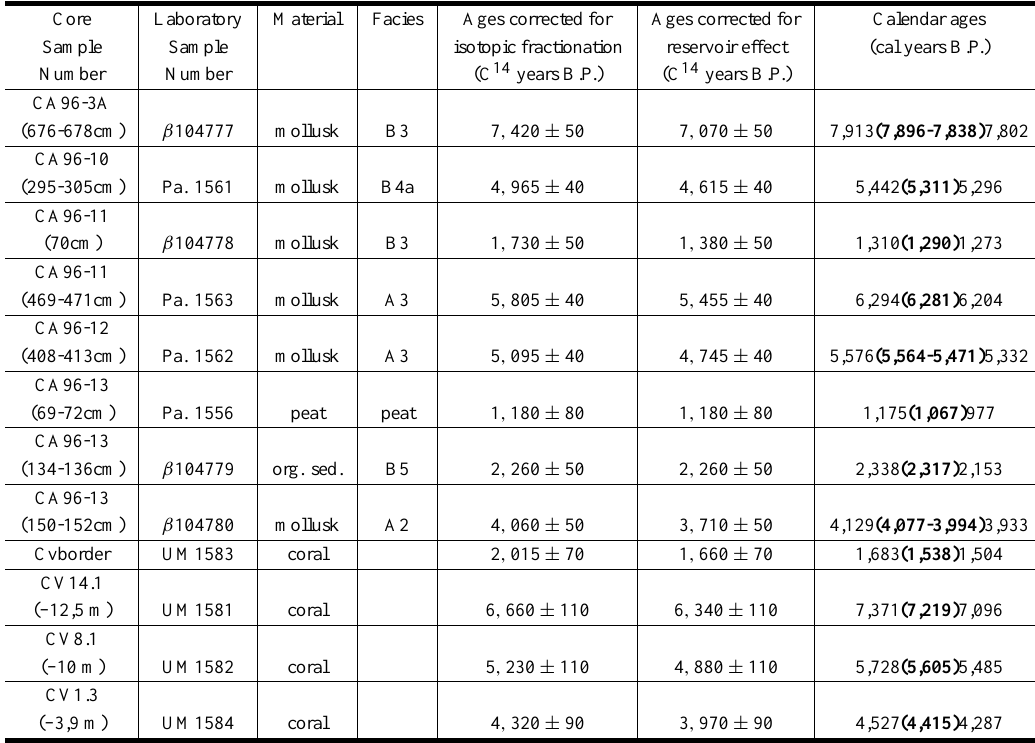
C 14 datings in vibracore